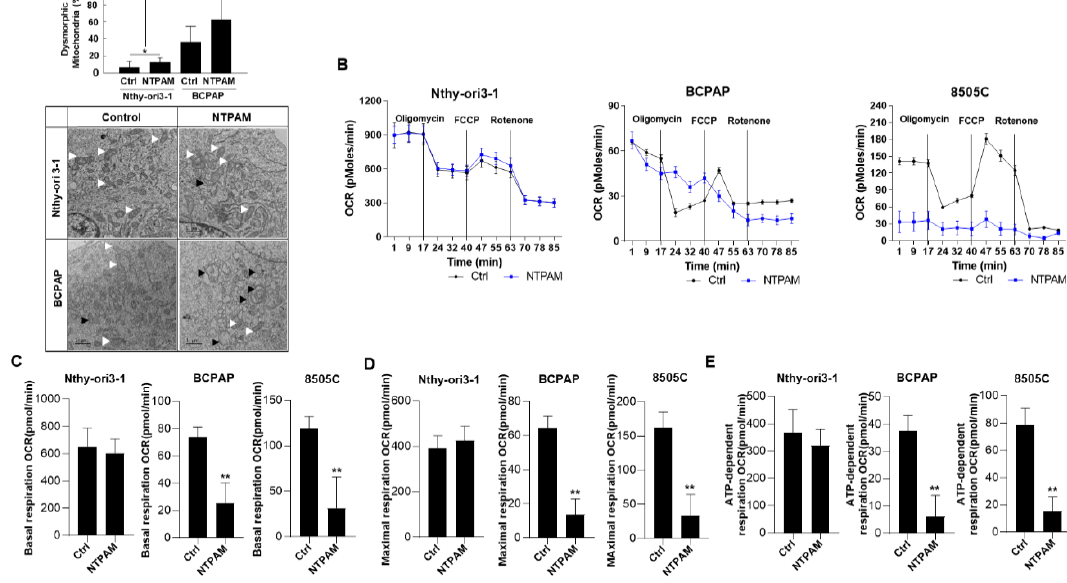
Figure 2. NTPAM induces mitochondrial dysfunction in THCA cells. ( A ) Electron microscopy examination of Nthy-ori3-1 and BCPAP cells to evaluate dysmorphic mitochondria with or without 2 h dose-NTPAM treatment for 1 h. Normal